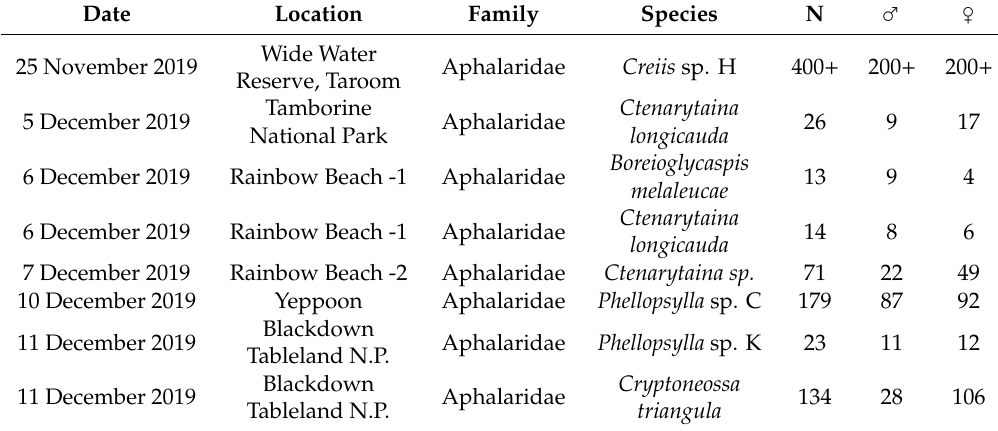
Table 3. Psyllid species collected with more than 10 individuals. The table includes date, location and data for each psyllid species collected with more than 10 individuals: family, species and number of males and females are reported.